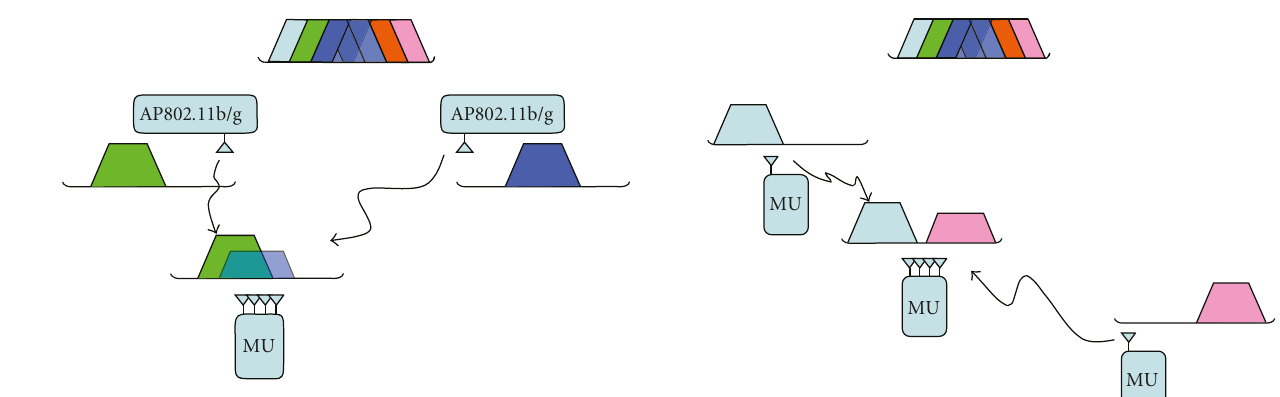
Figure 1: One multiband terminal receiving signals from two access points on overlapped channels.